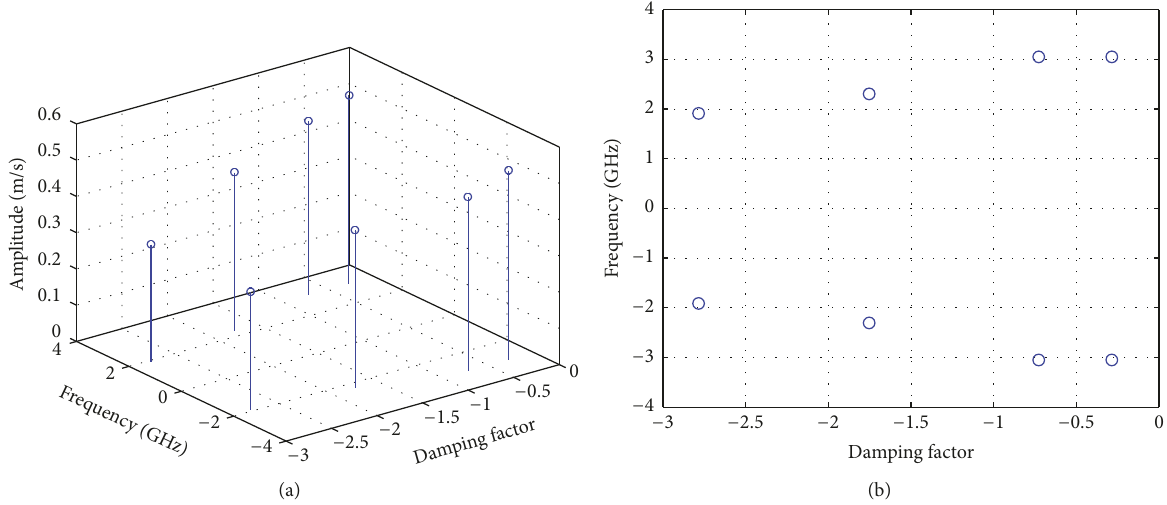
Figure 12: Using classical MP method: (a) pole-residue relationship and (b) frequency versus damping factor.